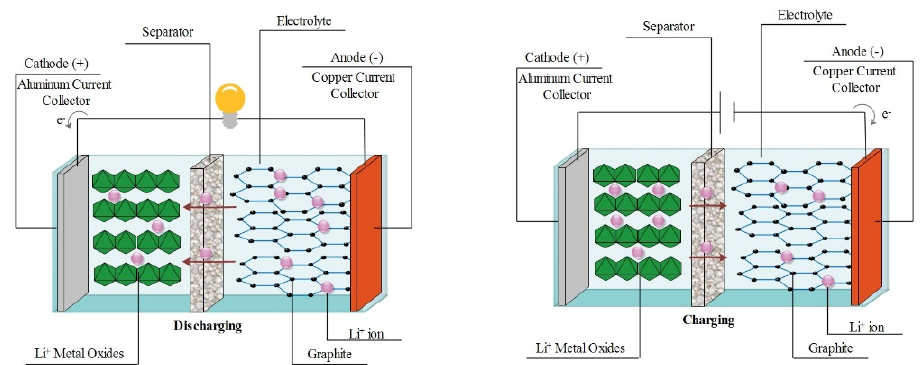
Figure 3. Schematic showing the intercalation mechanism in Li-ion batteries through charge and discharge. Reprinted from [85], with permission from Elsevier. discharge. Reprinted from [85], with permission from